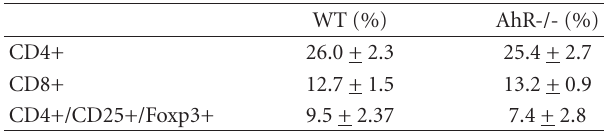
Table 2: Flow cytometric profiles of spleen cells stained for CD4+, CD8+, and CD4+/CD25+/Foxp3+ (Treg). Data are shown as % of T. gondii -specific CD4+, CD8+, and Treg cells from 4 to 5 mice per group.